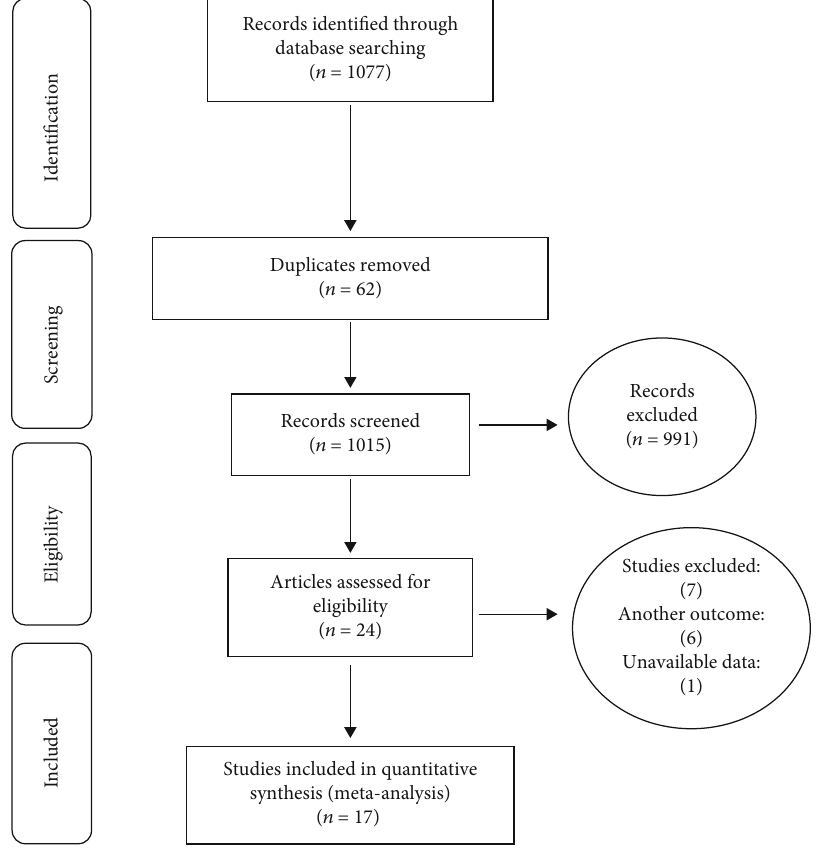
Figure 2: Flow diagram of study